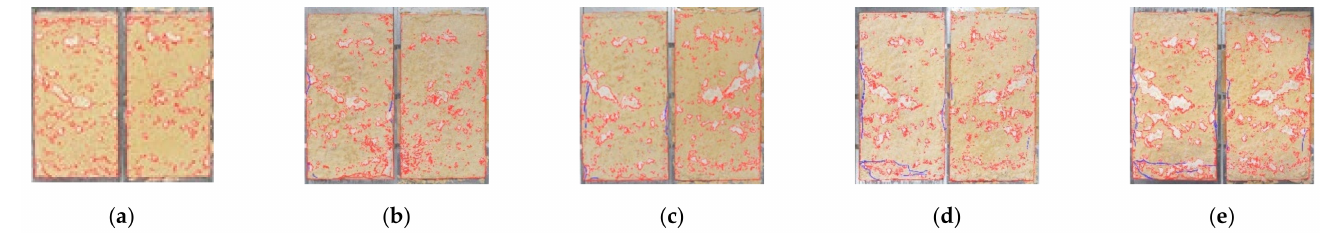
Figure 6. Failure modes of joints under diverse normal stiffness status. ( a ) For k n = 0; ( b ) For